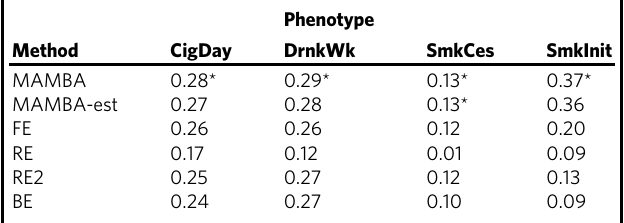
Table 2 Kendall ’ s tau correlation of p -values between discovery meta-analysis and replication p -value. The highest correlations were marked by an